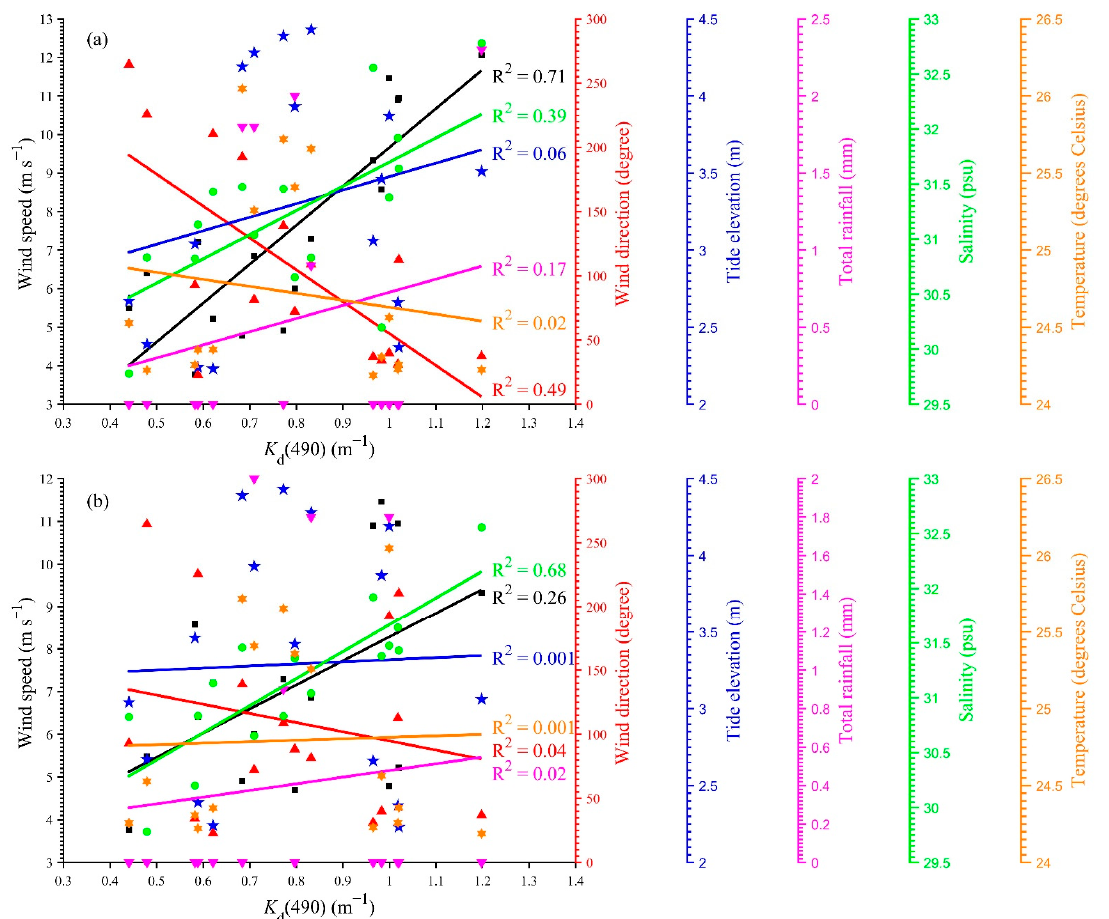
Figure 15. Correlations between daily mean K d ( 490 ) and daily mean wind speed (black), wind direction (red), tide height (blue), accumulated rainfall (pink), salinity (green), as well as temperature (orange). The panels ( a , b ) illustrate the relationships with a lag of 0 day and 1 day, respectively. The R 2 s from the linear regressions between K d ( 490 ) and different parameters are annotated.